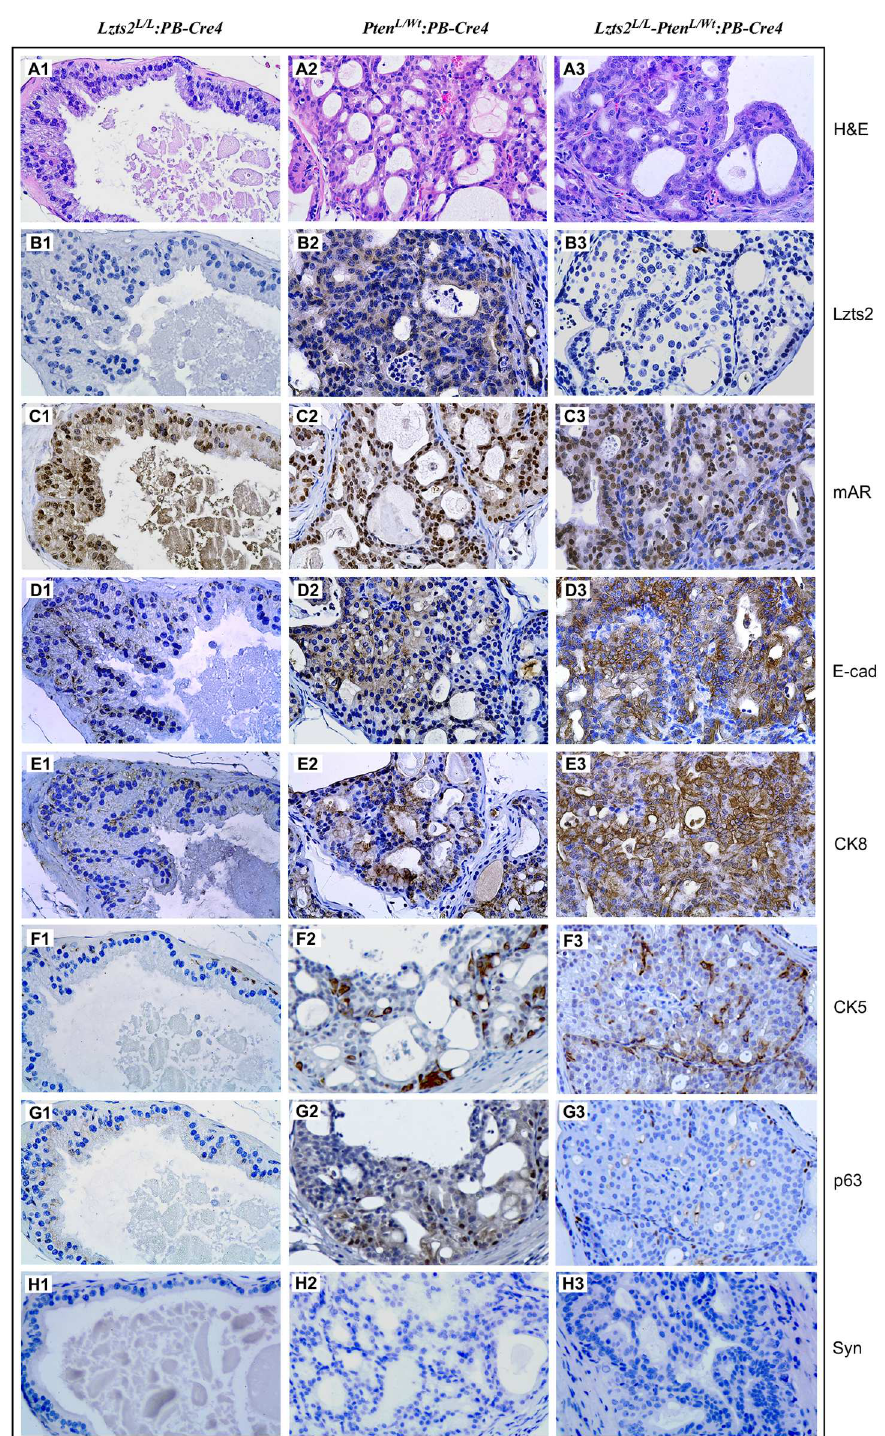
Fig 5. Mouse PINs from Lzts2 - Pten compound mice are composed primarily of luminal epithelial cells. Immunohistochemicalcomparisonof prostates from Lzts2 LoxP/LoxP : PB-Cre4 (panel1), Pten loxP/Wt : PB-Cre4 (panel2), and Lzts2 LoxP/LoxP -Pten loxP/Wt : PB-Cre4 (panel3) mice. Prostates were stainedwith H&E (Panels A1-A3) for histological comparisonand Lzts2 (B1-B3), mouse androgenreceptor(C1-C3), E-cadherin (D1-D3), cytokeratin 8 (E1-E3), cytokeratin 5 (F1-F3), p63 (G1-G3), and Synaptosin (H1-H3) to characterize the atypical cells.